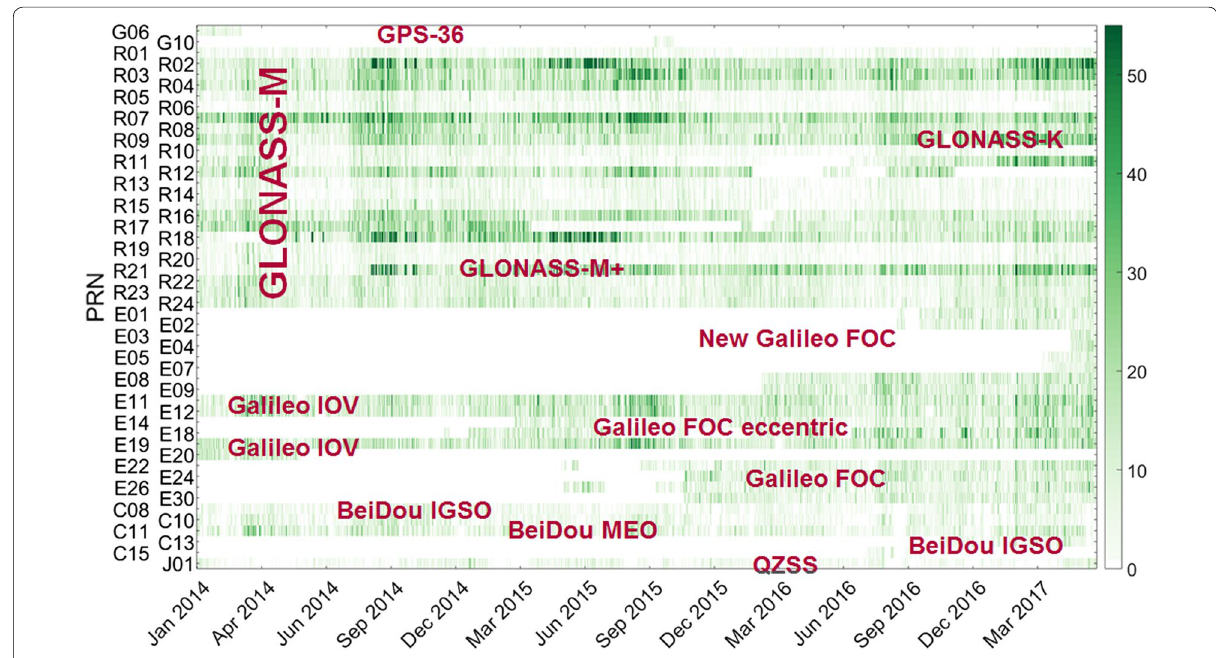
Fig. 1 Number of daily SLR observations to particular GNSS satellites between 2014.0 and 2017.4